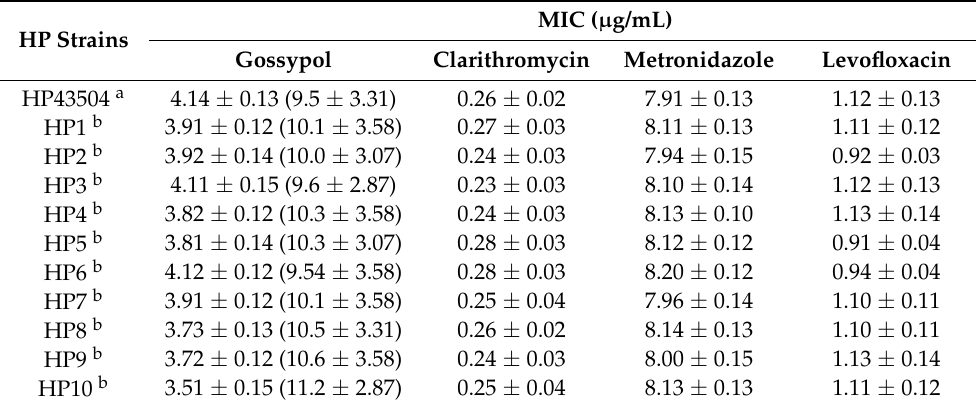
Table 1. Antibacterial effects of gossypol and standard antibiotics on HP strains. HP Strains